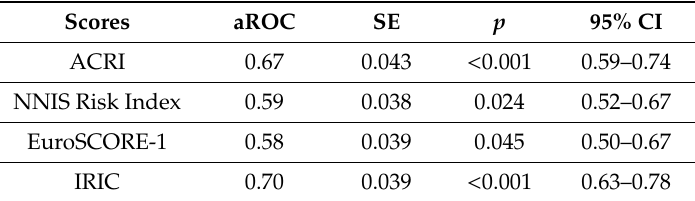
Figure 1. Independent aROC corresponding to IRIC, ACRI, NNIS risk index, and EuroSCORE-1 for the prediction of SSI in cardiac surgery patients (training sample). ACRI, Australian Clinical Risk Index; aROC, area under the Receiver-Operating Characteristic curve; CI, confidence interval; EuroSCORE, European System for Cardiac Operative Risk Evaluation; IRIC, Infection Risk Index in Cardiac surgery; NNIS, National Nosocomial Infections Surveillance. Table 4. Calculation of independent discrimination for IRIC, ACRI, NNIS risk index, and EuroSCORE-1 (training